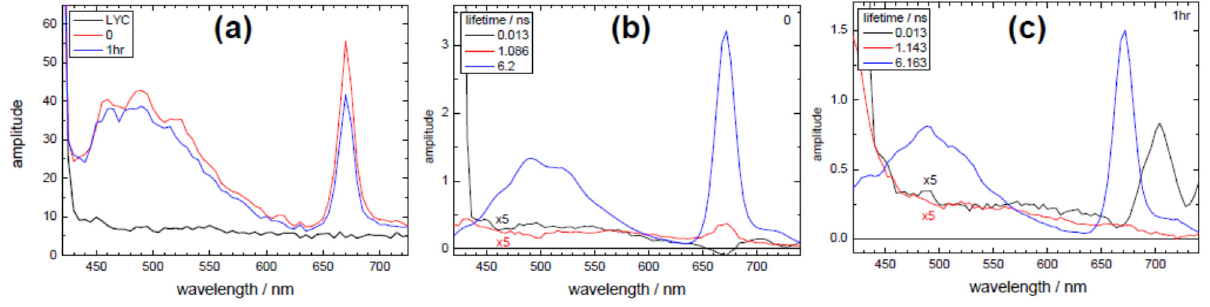
Figure 5. Results of TRES measurements, showing ( a ) the equivalent steady state spectra and the decay associated spectra for ( b ) the untreated extract and ( c ) extract treated for 1 h. Excitation was at 378 nm. Adapted from